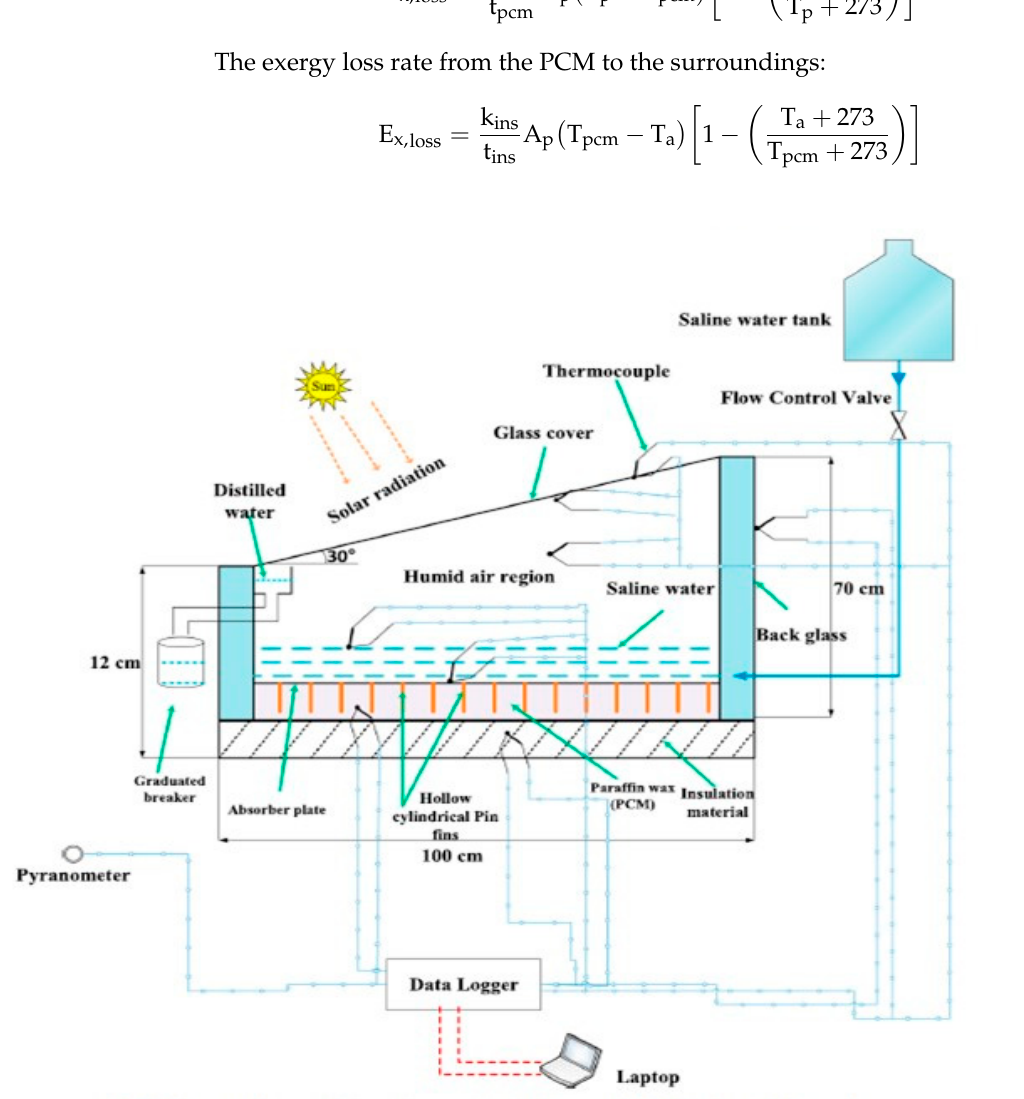
Figure 6. Schematic of the sloping solar still (source: Yousef and Hassan [59]).